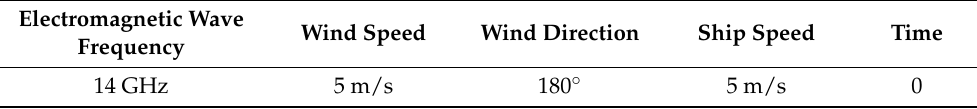
Figure 8. Backscattering coefficients for ( a ) HH polarization and ( b ) VV polarization. Table 2. Parameters required for